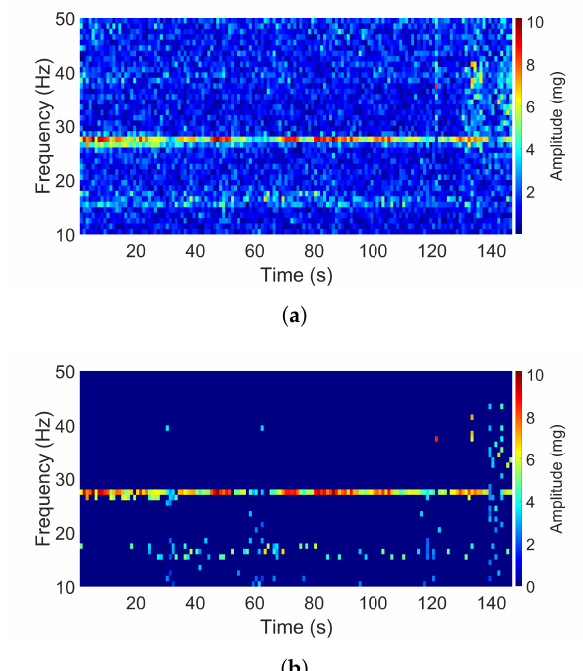
Figure 6. Spectrogram of the airplane passenger table signal (Y direction): ( a ) Original. ( b ) Filtered.